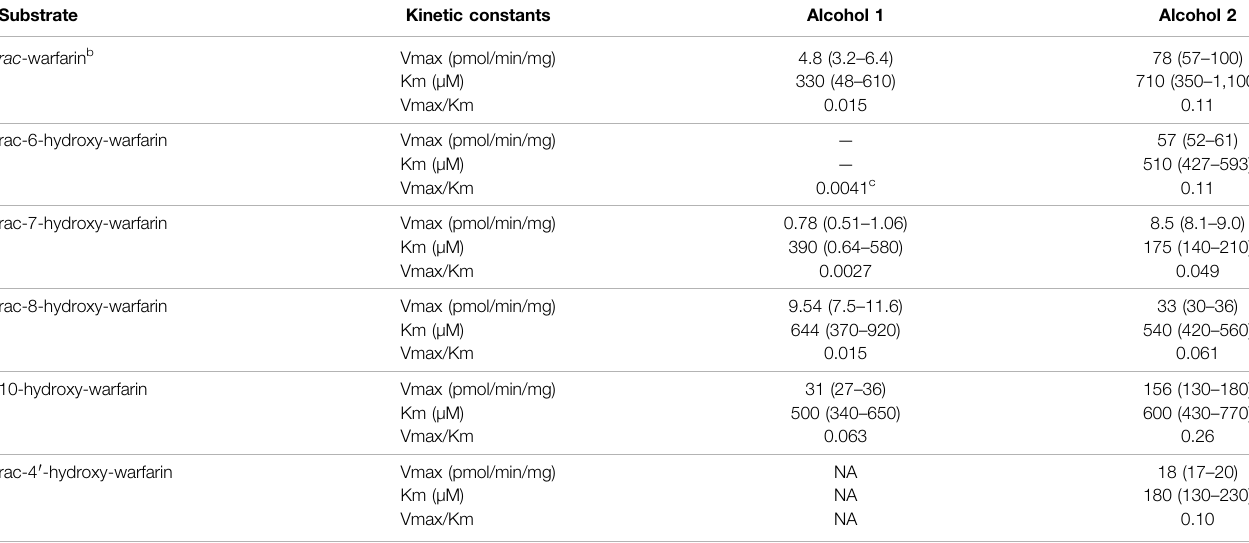
TABLE 2 | Michaelis-Menten kinetic parameters for reduction of warfarin and hydroxywarfarin isomers a .